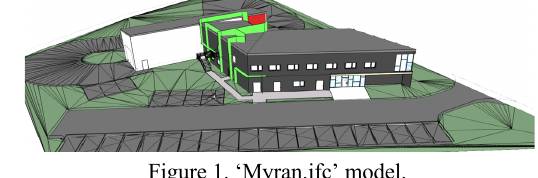
Figure 1. ‘Myran.ifc’ model.